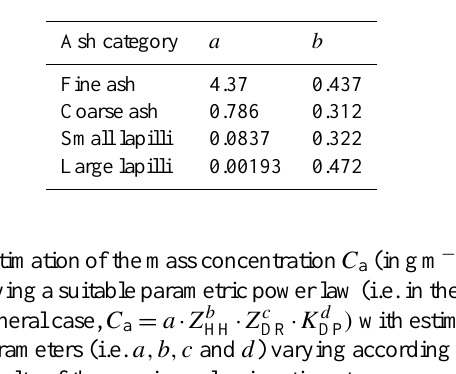
Table 2. Parameters for the ash concentration retrieval C a = a